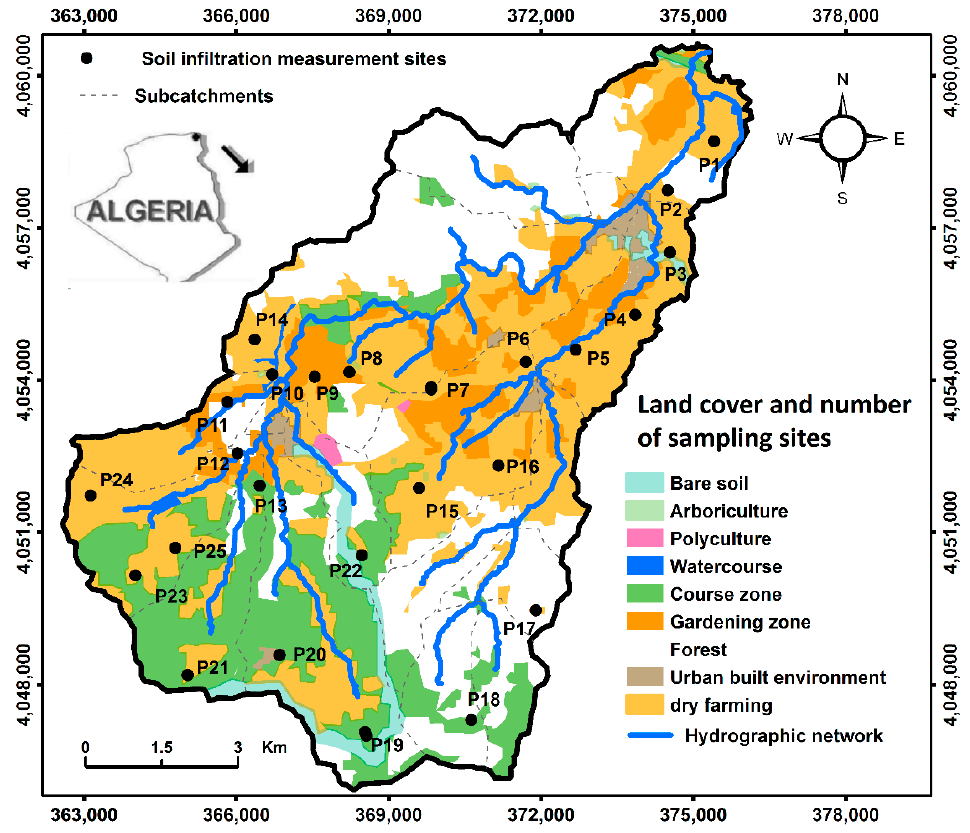
Figure 1. Land cover and hydrographic network of Madjez Ressoul catchment.